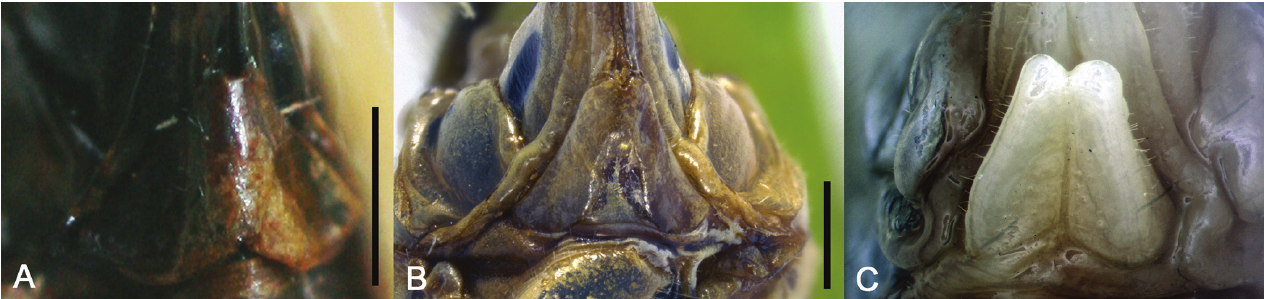
Fig. 4. Subgenital plates of female Lunidia species. A. L. viridis ; B. L. bicercata sp. n.; C. L. acuticercata . Scale bars: 1 mm.